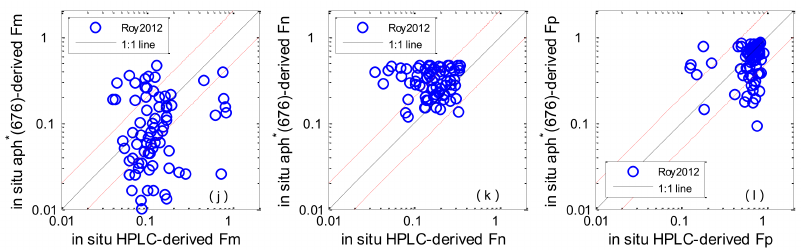
Figure 4. Scatter plots of estimated phytoplankton size classes (PSCs) versus in situ measurements: Uitz2006 ( a – c ); Brewin2010 ( d – f ); Hirata2011 ( g – i ); Roy2013 ( j – l ). The solid line is the 1:1 line. The red dashed lines are the 1:2 and 2:1 lines. Table 4. Statistical results for the validation of the selected algorithms using in-situ data. The slope is the linear regression results from retrieval values versus in situ ones. N is the number of